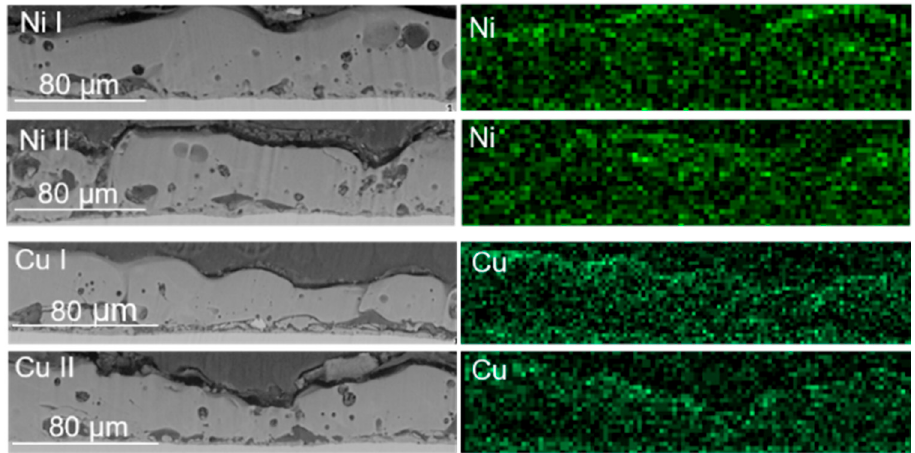
Figure 5. EDX analysis of samples prepared in the electrolytic bath with the addition of nickel and copper hydroxide.